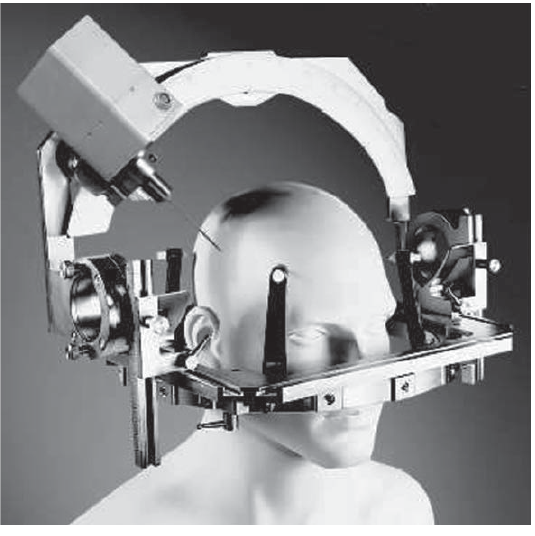
Fig. 3. Stereotactic